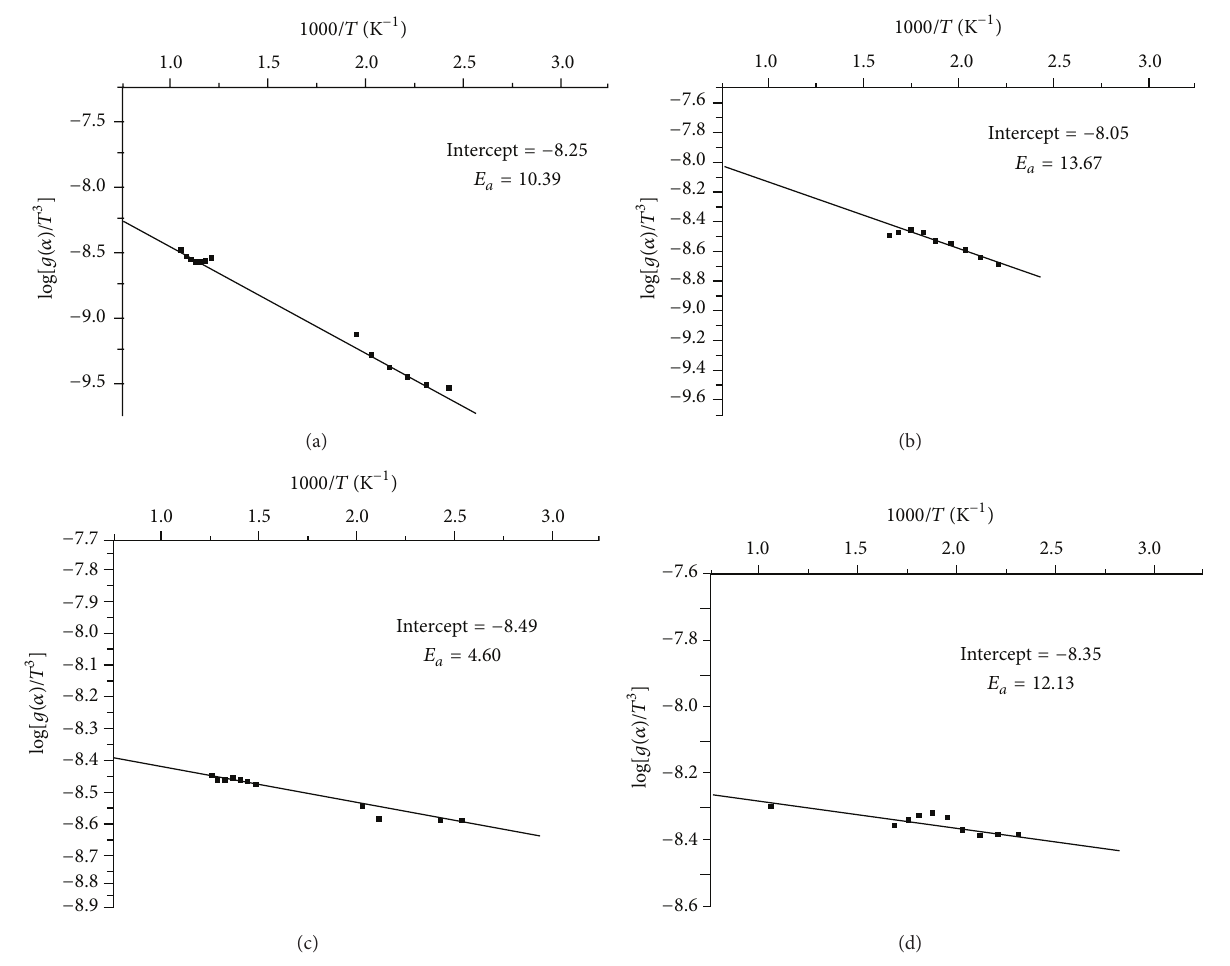
Figure 12: Freeman-Carroll plots ( 𝐸 𝑎 ) of (a) BEF ligand, (b) BEF–Cu, (c) BEF–Ni, and (d) BEF–Zn.